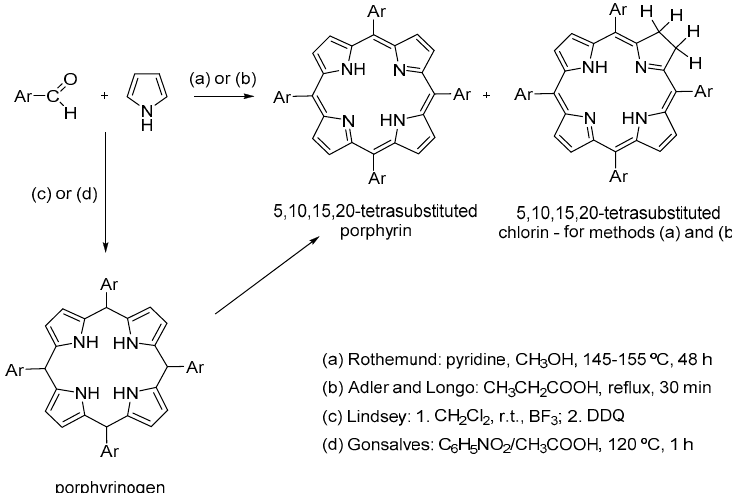
medium is also a friendly advantage of the oxidative mixture reported by the Portuguese